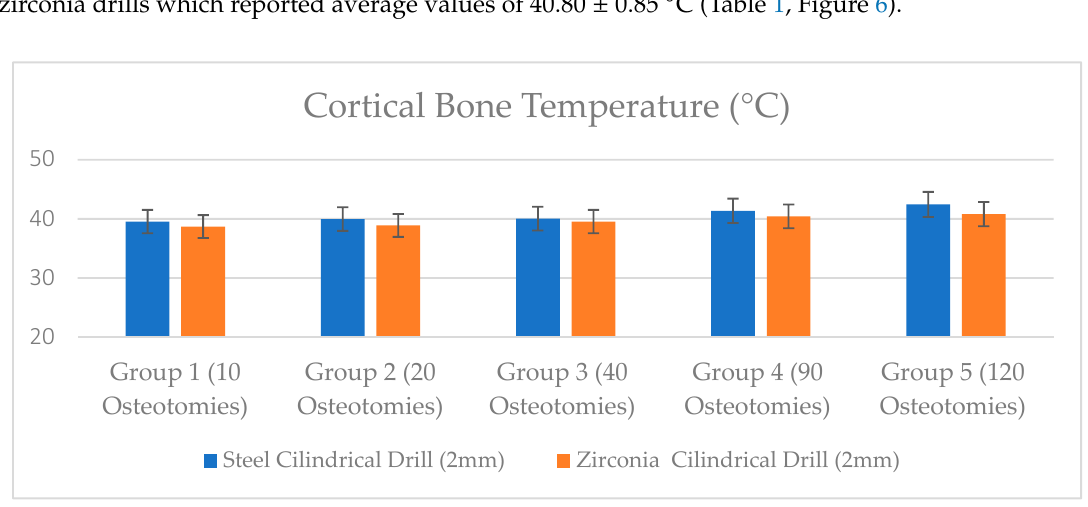
Figure 6. Bone temperature after site preparation with steel and zirconia drills.